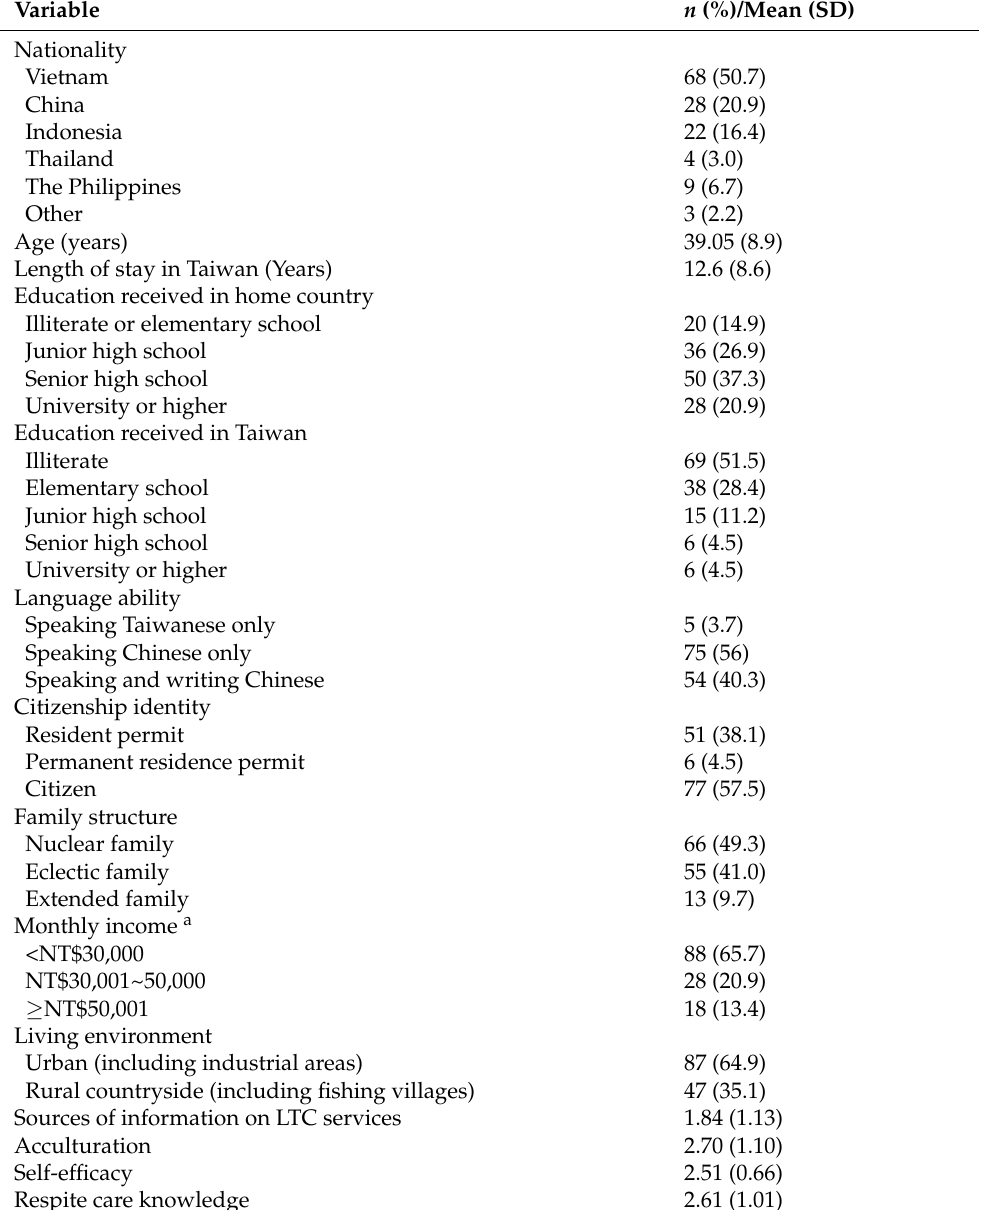
Table 1. Descriptive analysis ( n =